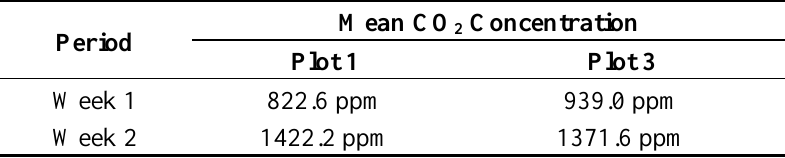
Table 4. Whole house mean CO 2 concentration